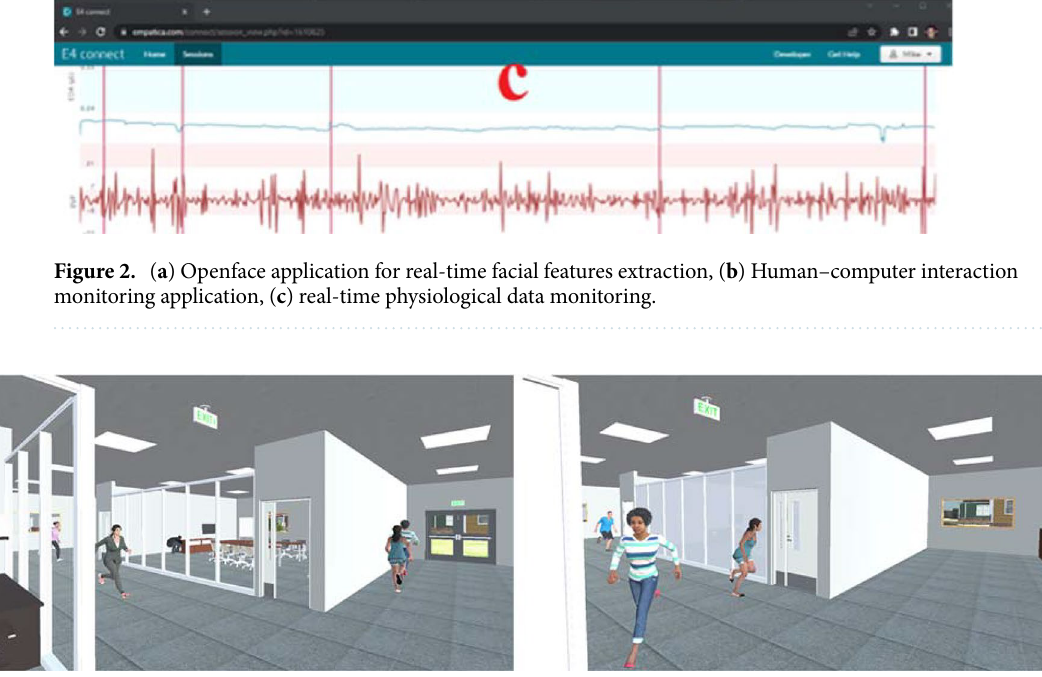
Figure 3. Empirical assessment of the impact of security countermeasures on human behavior during active shooter incidents. The images are from the participants’ perspective in a virtual reality-based experiment. Frosted glasses and access control are implemented in the right image. Non-player characters are included to represent social influence during building psychological and physical health consequences and leads to degraded productivity. On the other hand, when workers feel confident about handling their work stressors, they develop a feeling of eustress known as the posi- tive stress, responsible for motivating people to pursue their goals and to face challenges. Thus, differentiating between eustress and distress is a necessity for work organizations to promote eustress and limit distress among